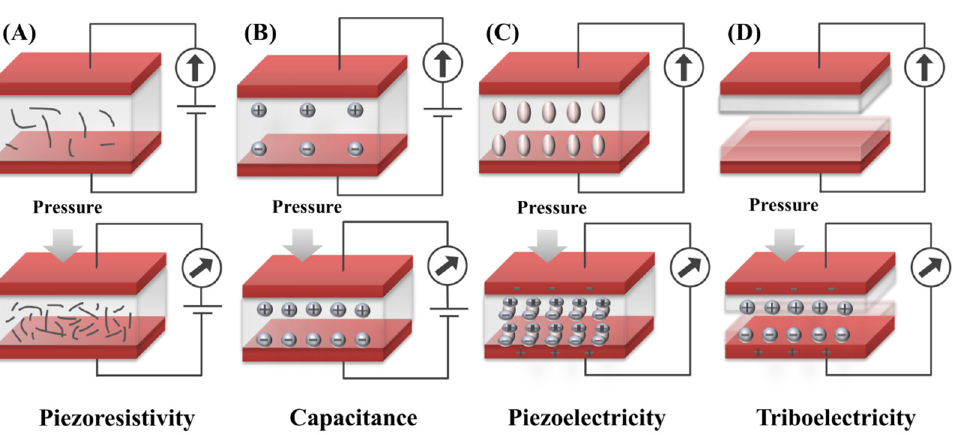
Figure 1. Schematic illustration of four sensing mechanisms: ( A ) Piezoresistivity; ( B ) Capacitance; ( C ) Piezoelectricity; ( D ) Triboelectricity.